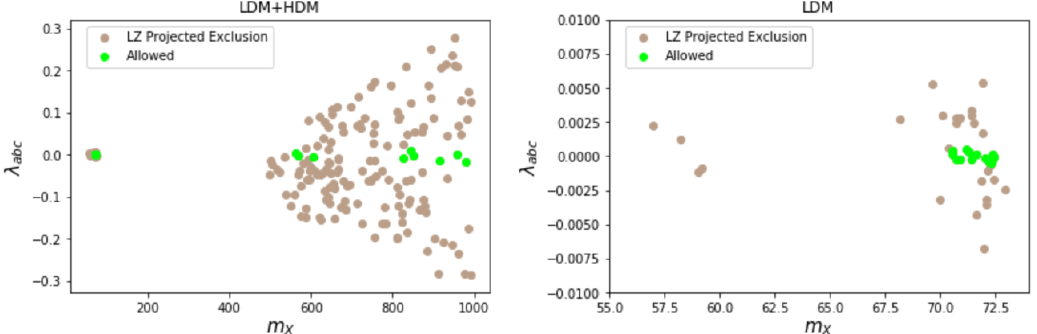
Figure 3 . LDM+HDM (left) and LDM (right) regions where points colored brown would be excluded by LZ projected upper limits while points colored green would still be